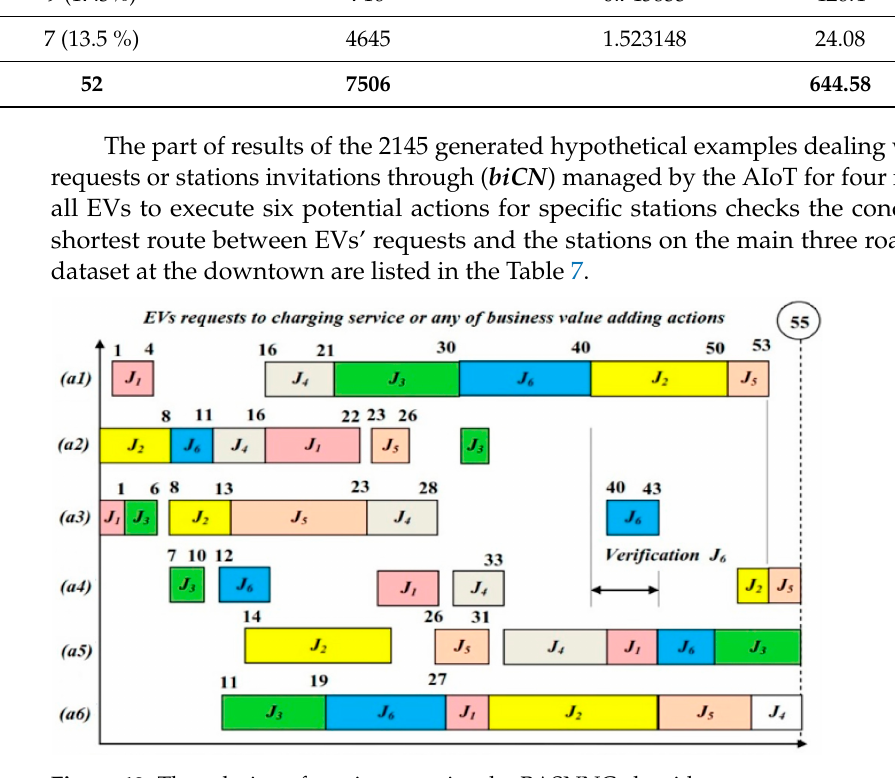
Figure 12. The solution of service span time by BASNNC algorithm.